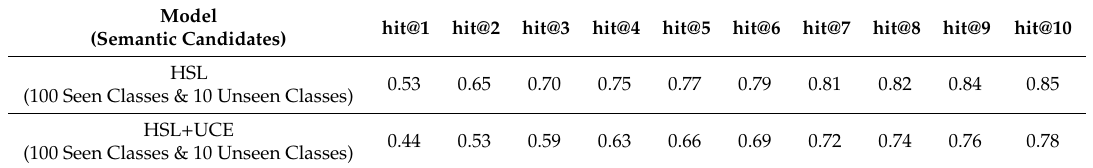
Table 4. Hit@k performance on visual-semantic cross-modal retrieval for seen class visual data in